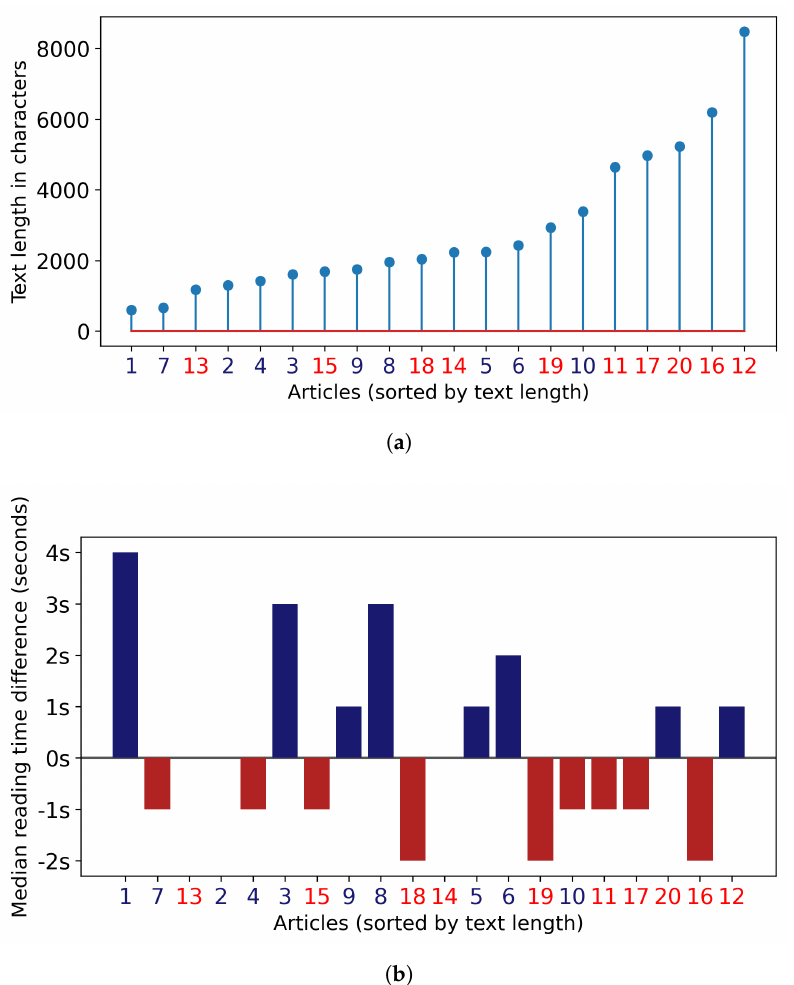
Figure 8. Articles’ full body length are not correlated with longer answering times. ( a ) Length of texts in Room 2. Articles’ bodies are sorted from the shortest to the longest. ( b ) Difference between the median answering time taken by users in Room 2 and all the other rooms on each article, with articles sorted by length. Apparently, there is no linear dependency of answering times on text